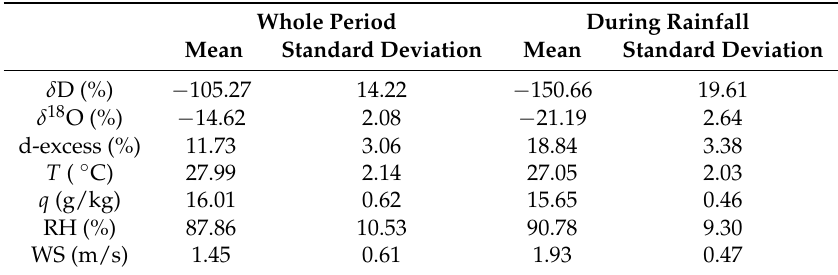
Table 1. Water vapor isotopic composition and atmospheric conditions observed at Gaoqiao Mangrove Reserve during July 2017. Whole Period During Rainfall Mean Standard Deviation Mean Standard Deviation δ D